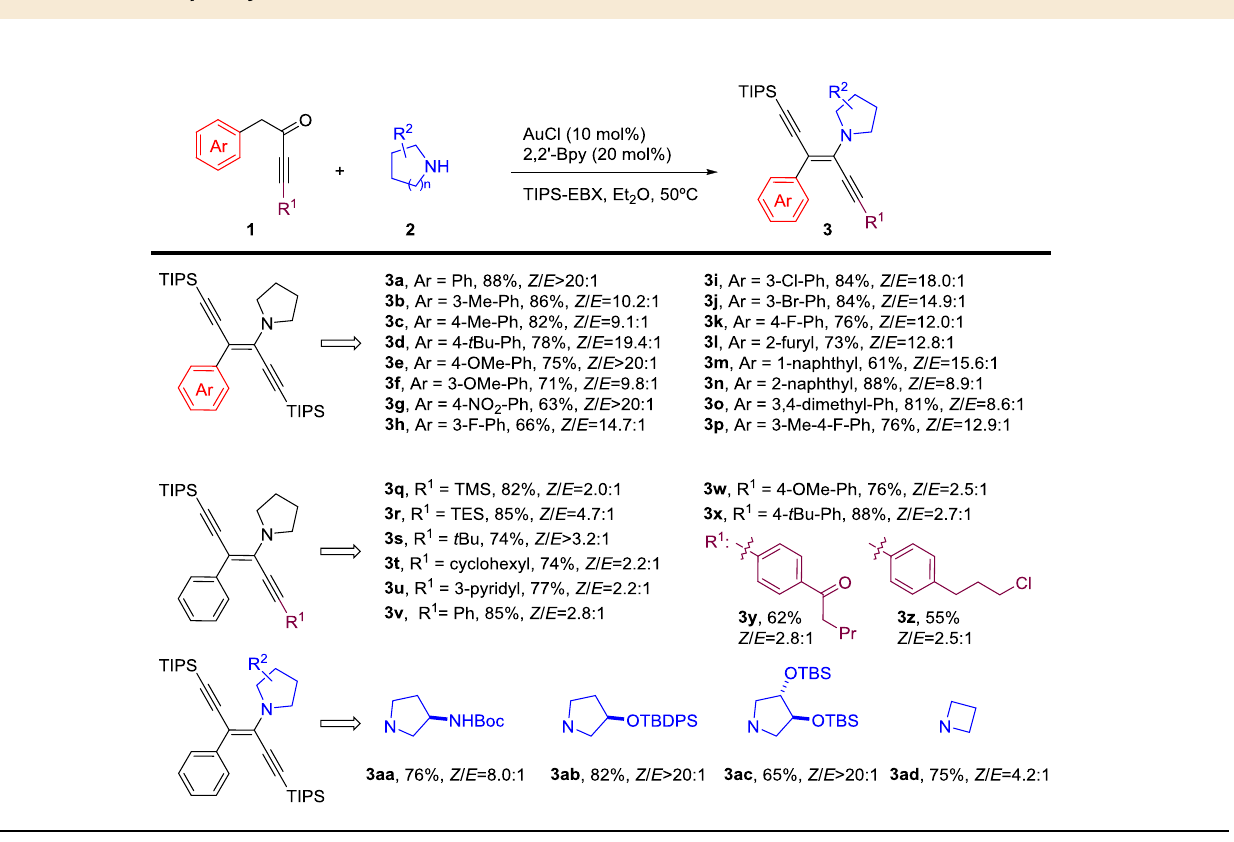
TMS: trimethylsilyl, TES: triethylsilyl, OTBS: tert-butyldimethylsilyloxy, OTBDPS: tert-butyldiphenylsilyloxy a Reactions were performed using 1 (0.1mmol), 2 (0.1mmol), TIPS-EBX (0.12mmol), AuCl (0.01mmol), and 2,2 ’ -bipyridine (0.02mmol) in Et 2 O (2.0mL) at 50°C under Ar for 10h. Isolated